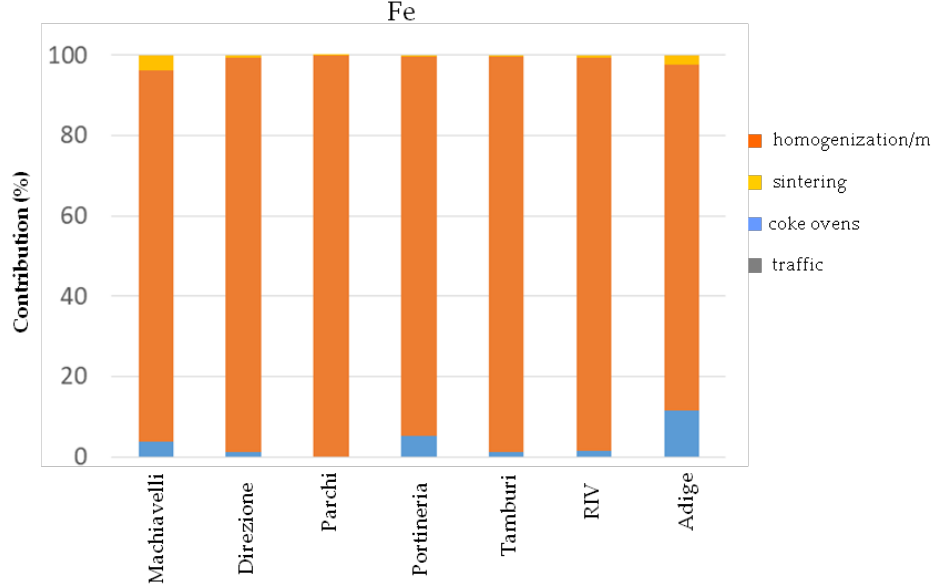
Figure 4. Percentage contribution of factors on Fe concentrations at the receptor sites. Int. J. Environ. Res. Public Health 2020 , 17 , x FOR PEER REVIEW